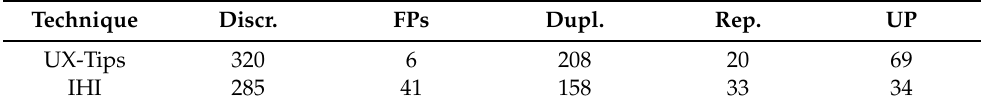
Table 14. Performance by technique. Technique Discr. FPs Dupl.